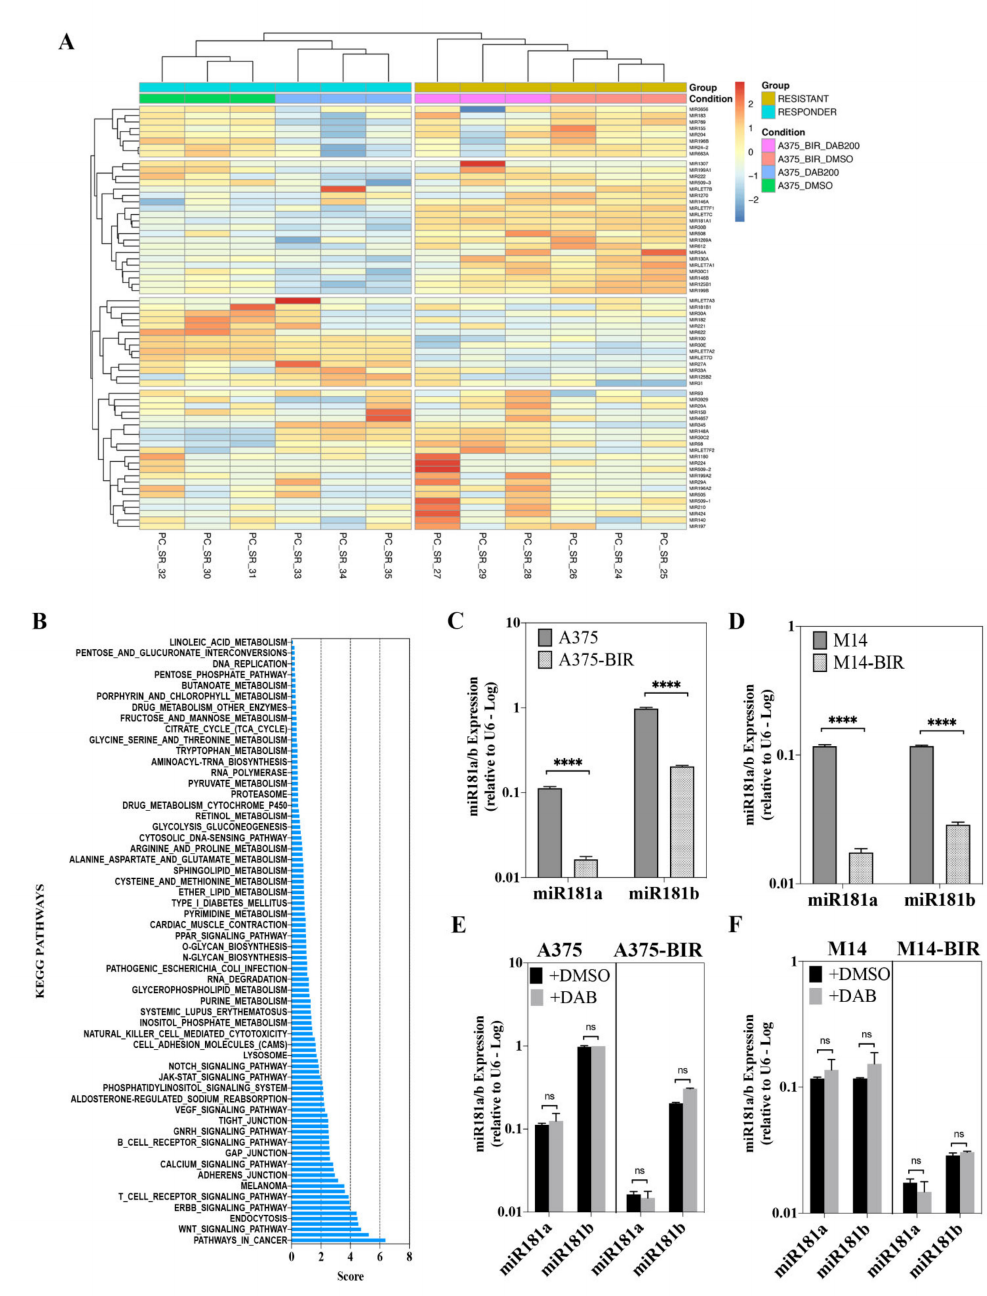
Figure 1. ( A ) Hierarchical clustering analysis and heat map based on the expression profiles of 65 miRNAs in responding and non-responding melanoma cells to dabrafenib treatment. Cluster analysis grouped samples and miRNAs according to similarity in expression. miRNAs are in rows and samples in columns. The miRNA clustering tree is indicated on the left and the sample clustering tree is at the top. Red color represents up-regulated expression and blue marks downregulated genes. Yellow indicates resistant cells and blue indicates responsive cells. miRNA, microRNA. To create the heatmap we converted the read counts into log2-counts-per-million (logCPM) values. ( B ) Putative target genes of differentially expressed miRNAs were obtained from TargetScan and used for KEGG pathway enrichment analysis. Only pathways with an adjusted p value < 0.01 were considered and listed according to a decreasing value of the combined score. ( C , D ) The expression levels of miR-181a and b in A375, A375-BIR, M14 and M14-BIR melanoma cells, measured by quantitative Real-Time PCR (qRT-PCR). ( E , F ) The expression levels of miR-181a and b in A375, A375-BIR, M14 and M14-BIR melanoma cells, treated with 200 nM dabrafenib (DAB) and vehicle control (DMSO), measured by qRT-PCR. The miRNA expression levels were normalized to the internal control U6. **** p < 0.0001; ns, not